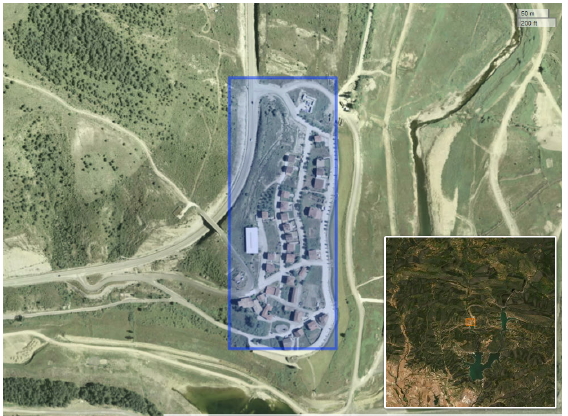
Figure A1. Satellite view of Nagore, a small community by the shoreline of the Itoiz reservoir. The main picture shows the buildings close to the shoreline. The smaller view at the bottom-right shows the location of Nagore (orange square) in relation to the lake. Images belong to the ESRI Wold Imagery Collection [72]. The graph was created using the package leaflet in R